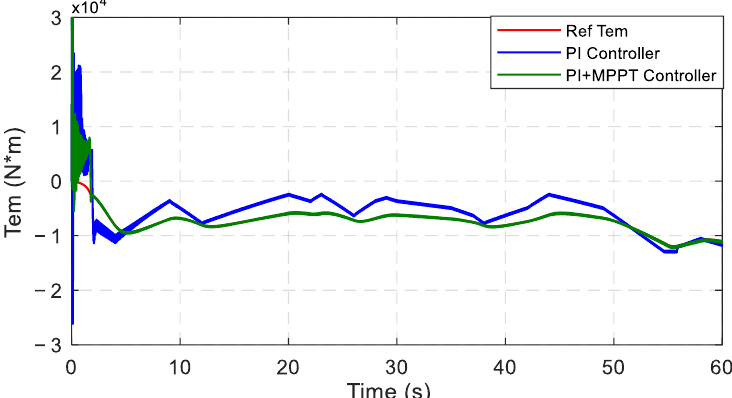
Figure 16. Grid currents of WECS with the proposed controller.